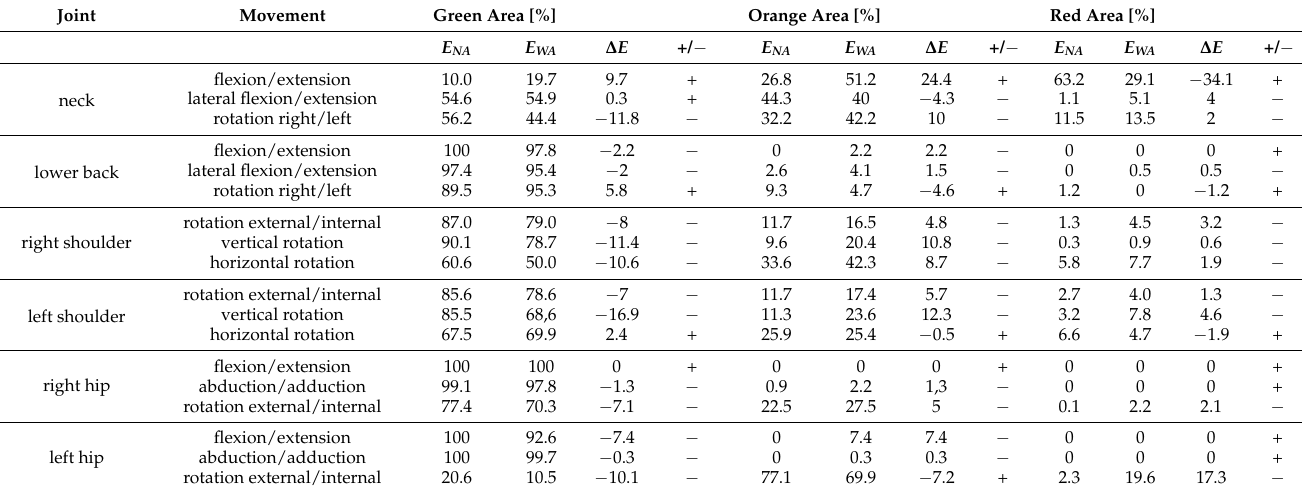
Table 3. Results from the comparative motion measurements with the Captiv system: for one worker when working without exoskeleton STAND ( E N ), and with exoskeleton EXO ( E W ). The results A A obtained correspond to the level of exposure to the risk divided in three zones—green, orange, red. ∆ E A —is the difference value to compare both types of experiments, E W —is the ratio between A durations of times when the observable occurs in one of three risk zones for measurement EXO, E N —is the ratio between durations of times when the observable occurs in one of three risk zones A for measurement STAND. The signs +/ − in the next column declare positive (+) or negative ( − ) influence of a particular change in the risk.